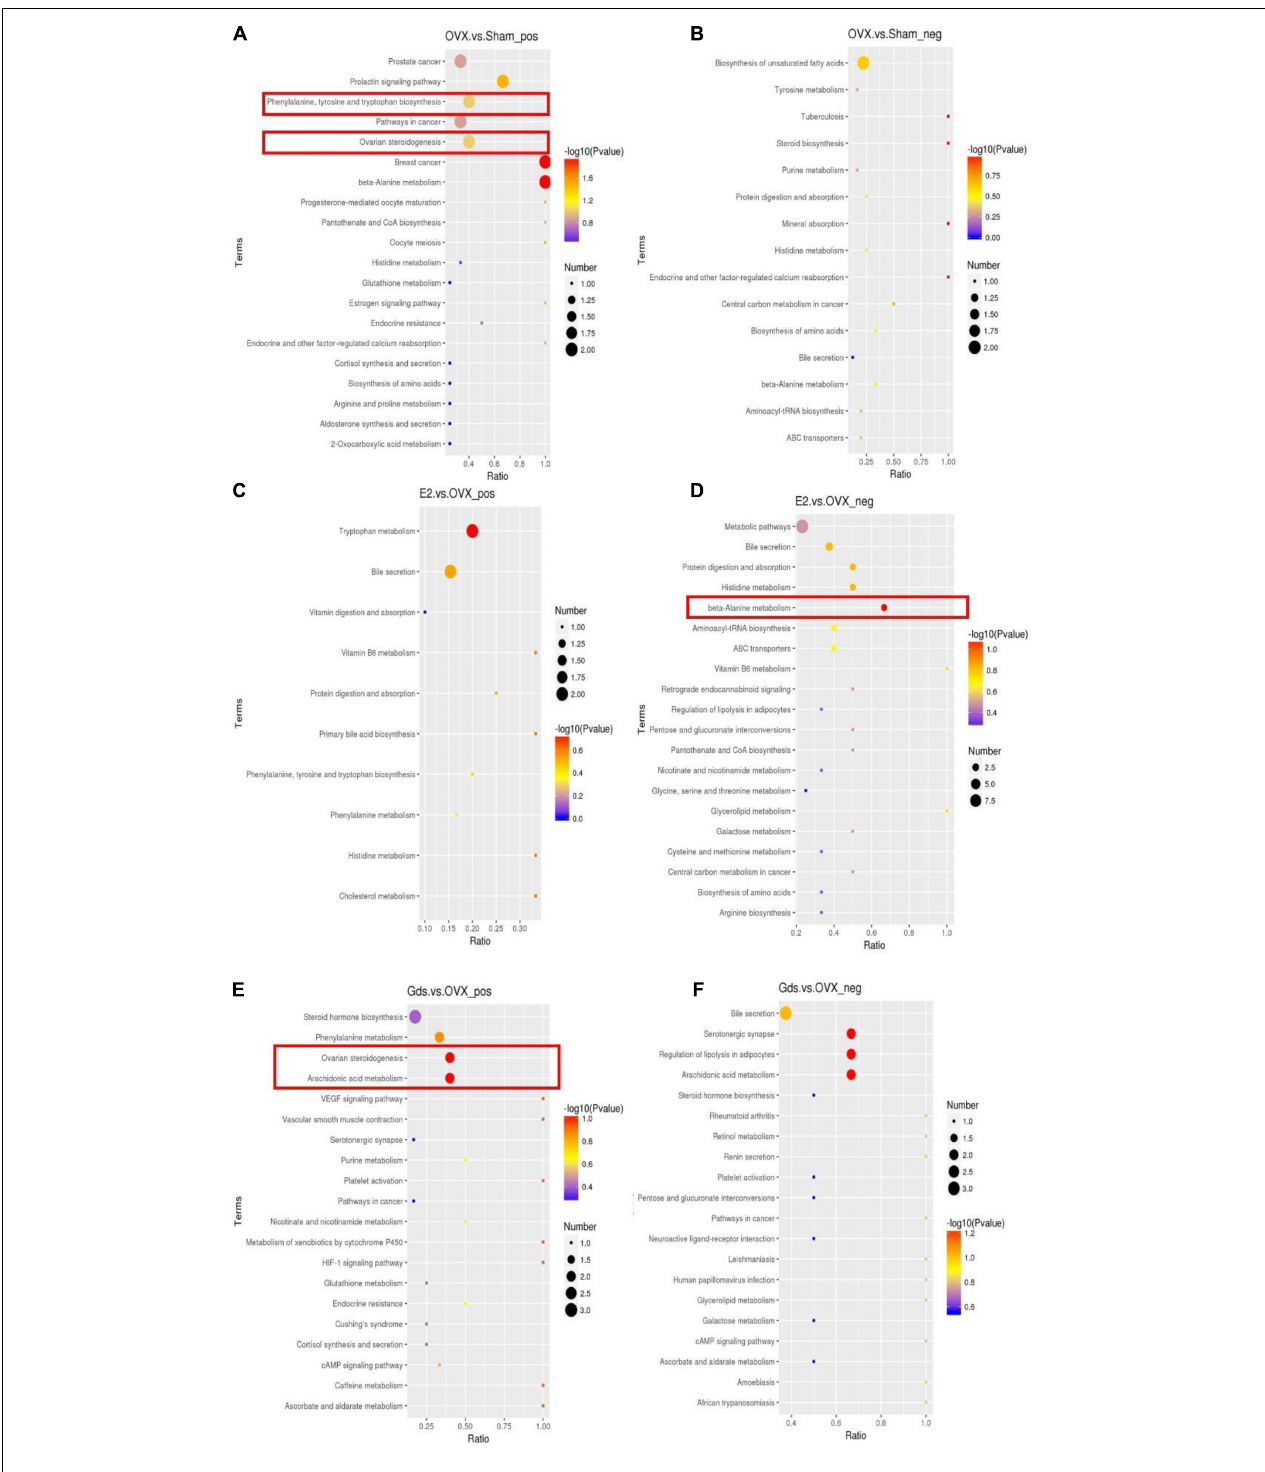
FIGURE 4 | Gds protected ovariectomized rats against the increasing of fat synthetic via metabolic signal pathway. (A) Top 20 results of KEGG enrichment signal pathway at positive ion model of OVX. vs. Sham; (B) top 20 results of KEGG enrichment signal pathway at negative ion model of OVX. vs. Sham; (C) top 20 results of KEGG enrichment signal pathway at positive ion model of E2. vs. OVX; (D) top 20 results of KEGG enrichment signal pathway at negative ion model of E2. vs. OVX; (E) top 20 results of KEGG enrichment signal pathway at positive ion model of Gds. vs. OVX; (F) top 20 results of KEGG enrichment signal pathway at negative ion model of Gds. vs. OVX. Sham, sham-operated group; OVX, ovariectomized control group; Gds, Gadus morhua sialoglycoprotein-treated group; E2, positive drug control group.